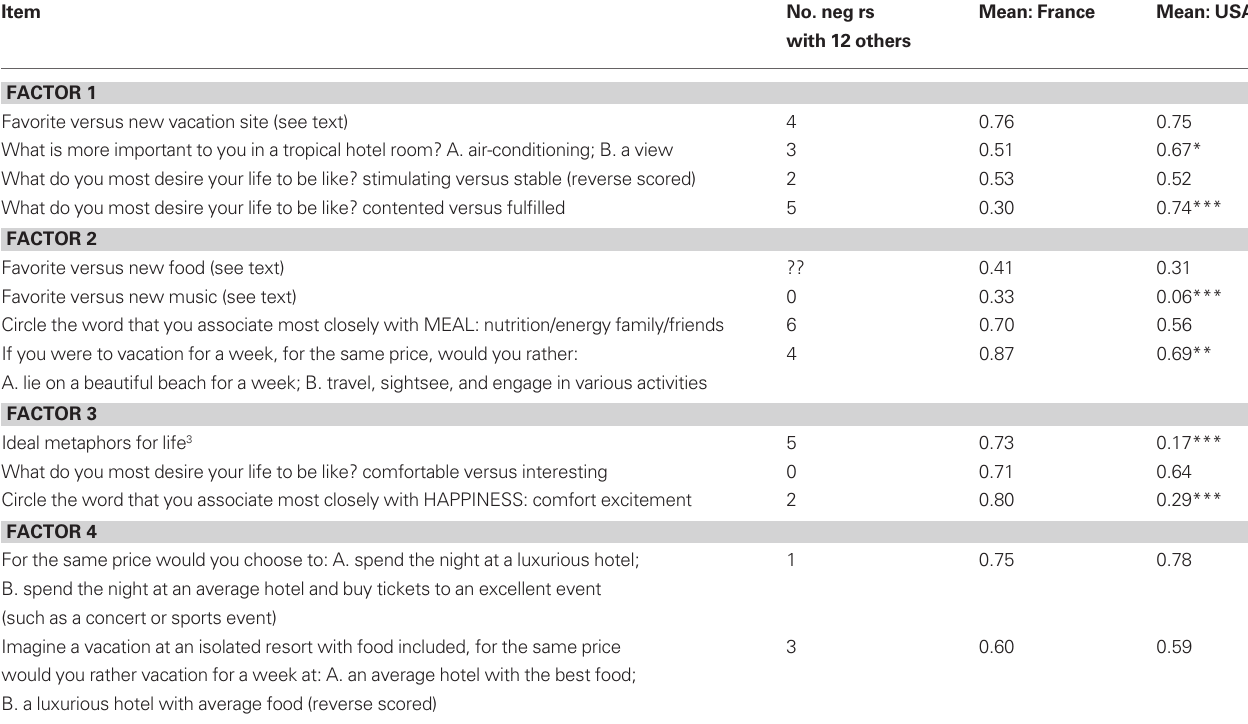
Table 6 | French and American scores on 13 items bearing on comforts versus joys 1